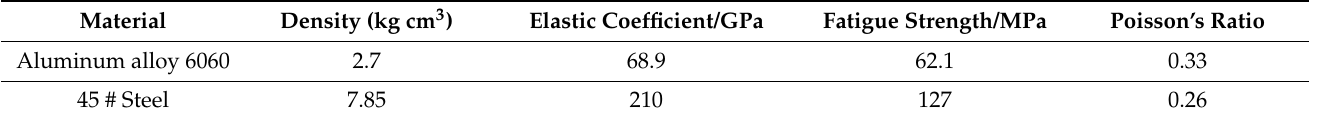
Table 1. Material mechanical parameter.